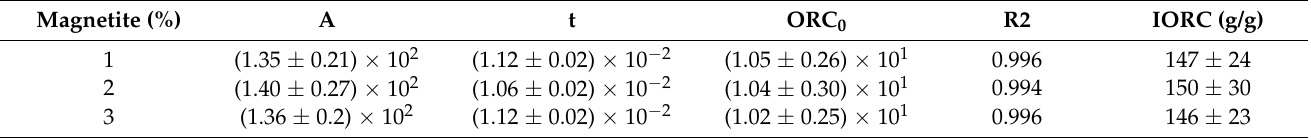
Table 1. Data obtained in exponential decay.